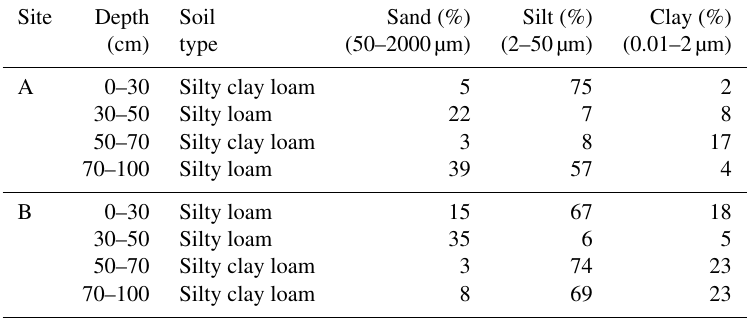
Table 4. Soil texture of Field A and